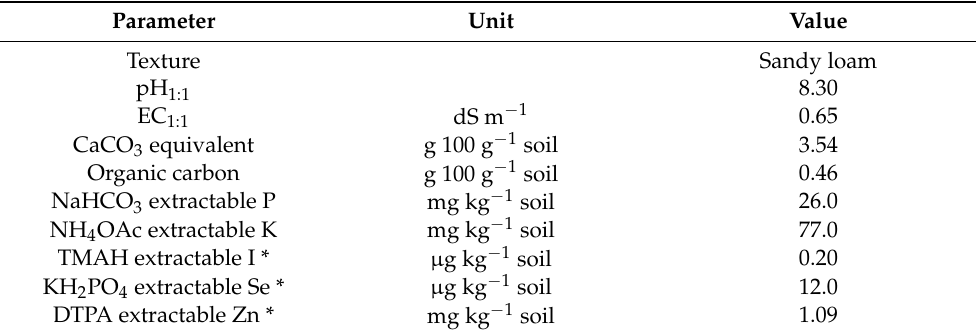
Table 1. Physicochemical properties of soil of the experimental